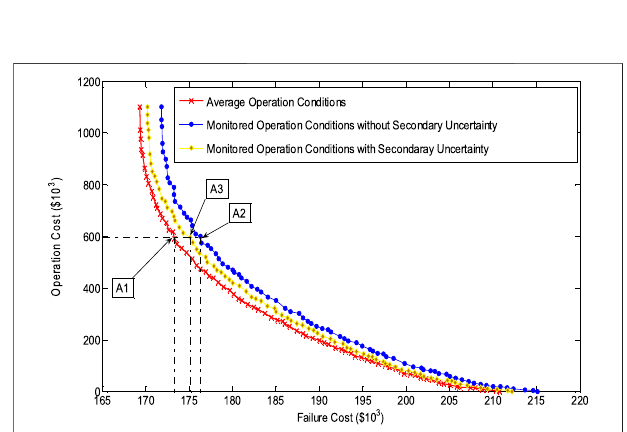
FIGURE 16 | Pareto front of the wind power plant: failure cost vs. operation